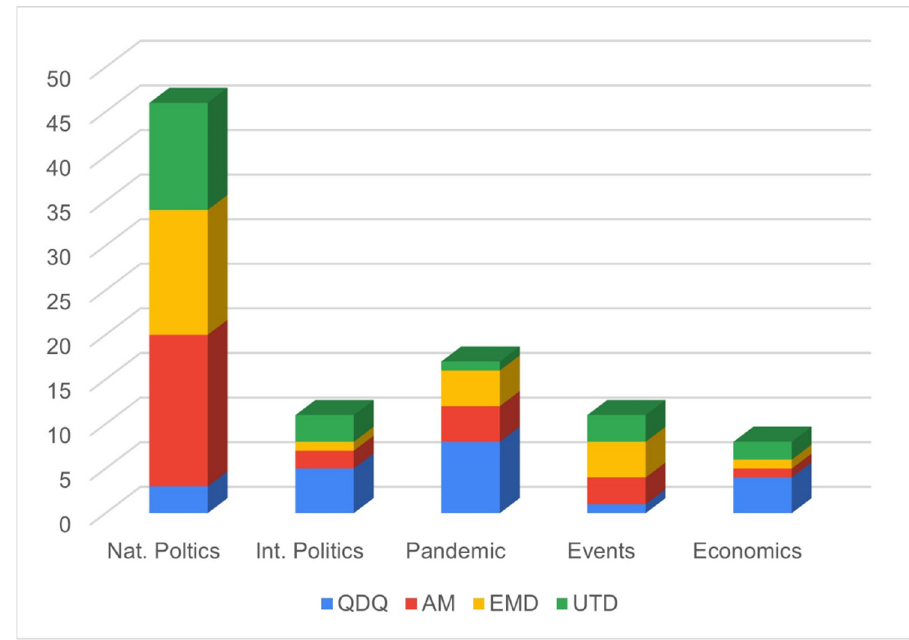
Figure 4. Sections of the four podcasts analyzed. Source: Prepared by the authors.